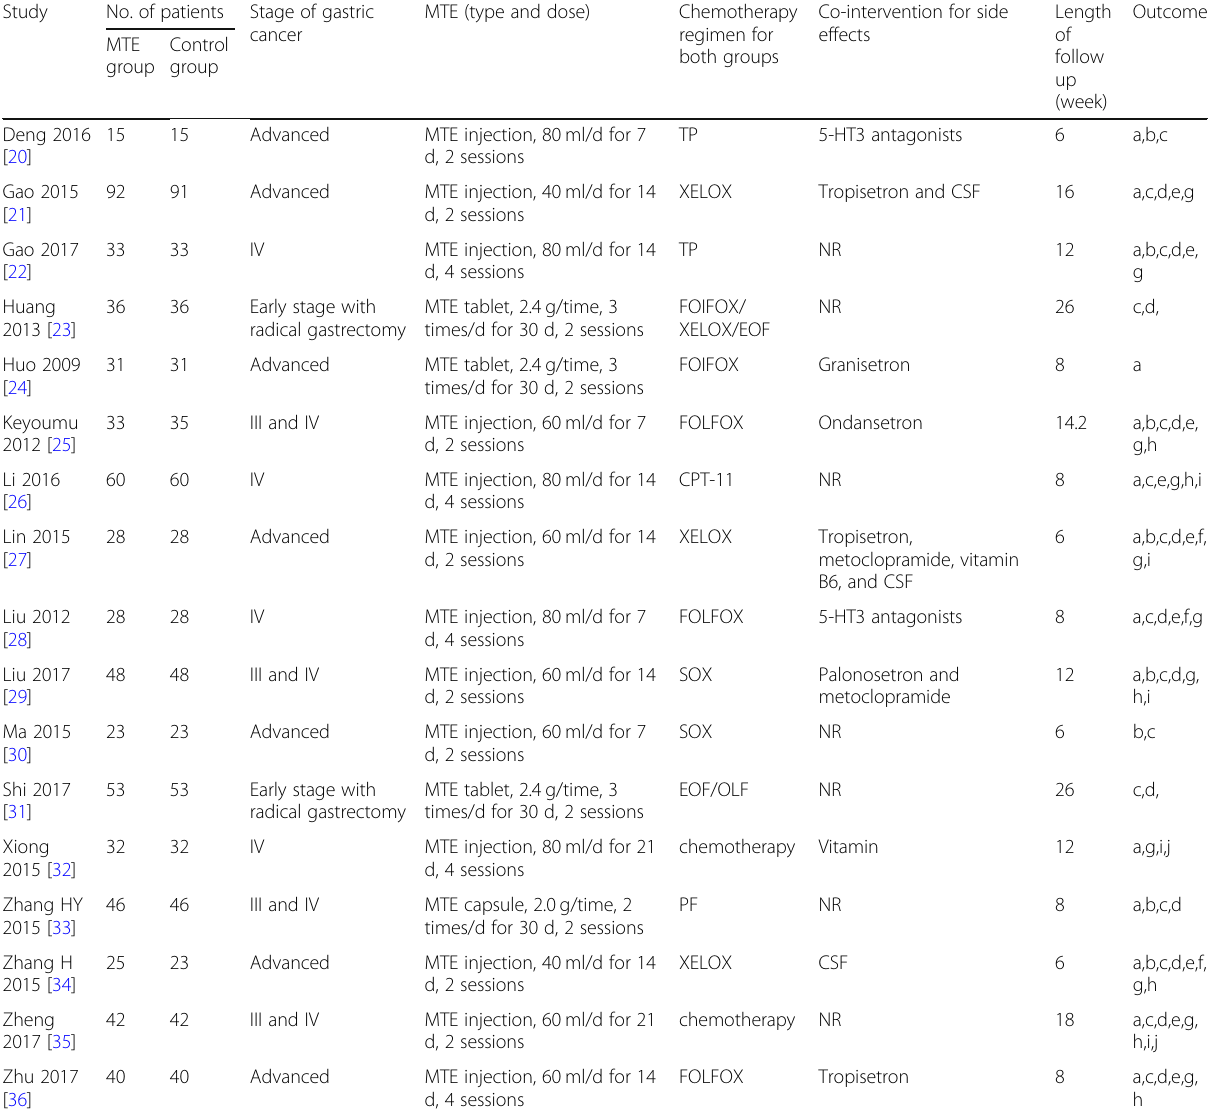
Table 1 Characteristics of included randomized controlled trials Study No. of patients Stage of gastric